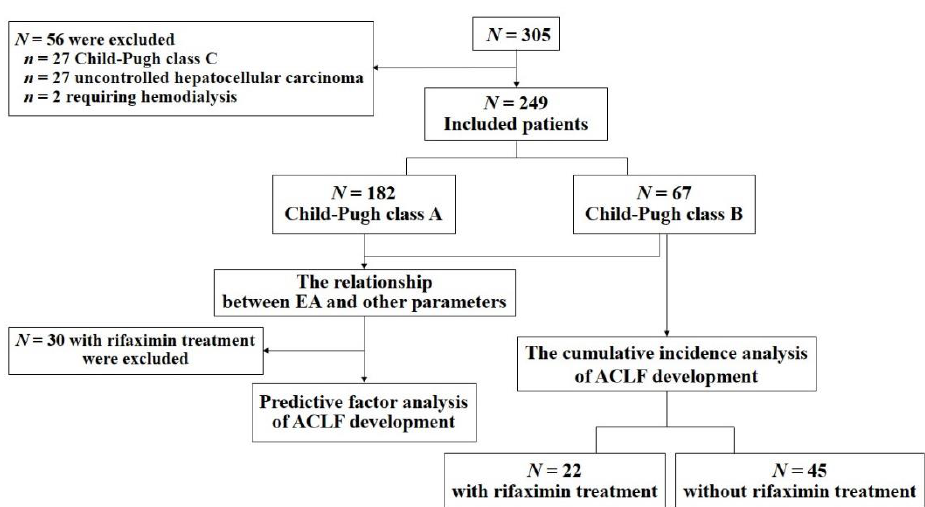
Figure 1. Flow chart of the study. Patients with Child-Pugh class C, uncontrolled hepatocellular carcinoma, and hemodialysis were excluded. The analysis included 249 patients, and 30 out of 249 patients were treated with rifaximin. We initially studied the relationship between endotoxin activity (EA) and other parameters in 249 cirrhotic patients with Child-Pugh class A and B. Subsequently, we investigated the predictive factor of acute-on-chronic liver failure (ACLF) development in 219 cirrhotic patients with Child-Pugh class A and B who were not treated with rifaximin. Sixty-seven patients out of 249 patients were Child-Pugh class B and 22 patients out of 67 patients with Child-Pugh class B were treated with rifaximin. Finally, we studied the relationship between rifaximin treatment and ACLF development in cirrhotic patients with Child-Pugh class B. EA, endotoxin activity; ACLF, acute-on-chronic liver failure.